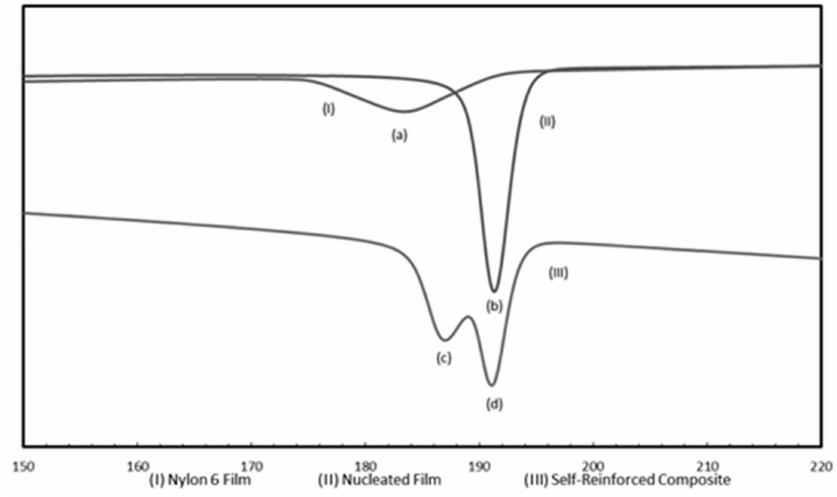
Figure 16. DSC cooling scans from the melts of (I) asr-N-6, (II) nuc-N-6, and (III) asr-N-6 / nuc-N-6 sandwich films. Peaks ( a ), ( b ), ( c ), and ( d ) correspond to T c s of 183.5, 191.5, 186, and 191.1 ◦ C, respectively. Reproduced with permission from [45]. Copyright 2011 Elsevier